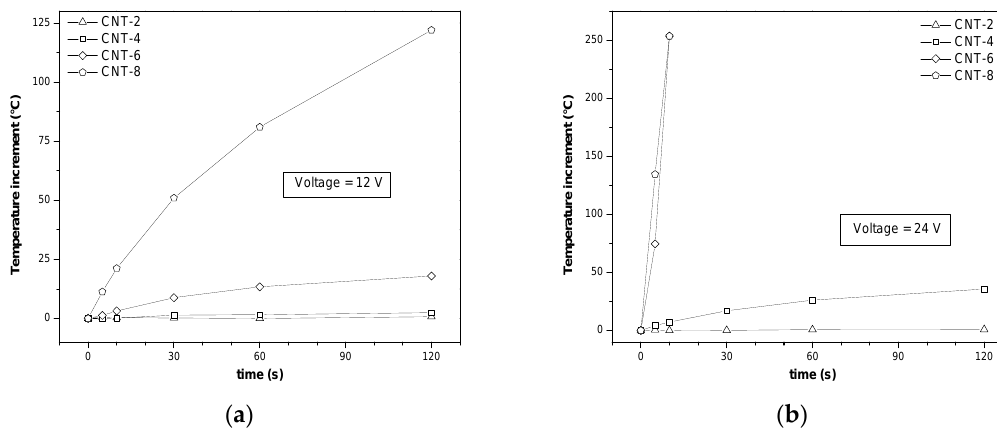
Figure 12. Increment of surface temperature as a function of time for voltage of 12 V ( a ) and 24 V ( b ) applied to ABS/CNT nanocomposites with different fractions of CNT content (starting temperature of 23 °C) .